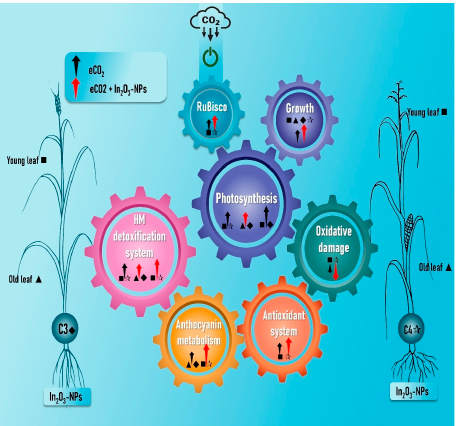
Figure 7. Infographic diagram that summarizes the impact of eCO 2 and/or In 2 O 3 -NPs upon both old and young leaves of C3 and C4 plants. Black and red arrows indicate either increase or decline due to eCO 2 or eCO 2 + In 2 O 3 -NPs, respectively. Supplementary Materials: The following are available online at www.mdpi.com/xxx/s1, Figure S1: A photograph that illustrates the differential effects of eC2 either lonely or in combination with In2O3-NPs upon the biomass of C3 and C4 plants, Table S1: A three-way ANOVA for the effect of treatment (Trt.) with eCO2, the plant species (Sp.) and the stage of plant leaf (St.) as well as their interaction on the biomass and photosynthesis as well as the molecular antioxidants and the oxida- tive markers (numbers represent F values; ns = non-significant; * = P < 0.05; ** = P < 0.01; *** = P < 0.001, **** = P < 0.0001). Table S2: A three-way ANOVA for the effect of treatment (Trt.) with eCO2, the plant species (Sp.) and the stage of plant leaf (St.) as well as their interaction on the ascorbate/glu- tathione biosynthetic pool as well as detoxification system and anthocyanin metabolism (numbers represent F values; ns = non-significant; * = P < 0.05; ** = P < 0.01; *** = P < 0.001, **** = P < 0.0001) Author Contributions: Conceptualization, M.M.Y.M. and H.A.; methodology, M.M.Y.M., and H.A.; software, M.M.Y.M., H.A and I.I.S.; validation, M.M.Y.M., H.A and I.I.S.; formal analysis, I.I.S. and M.A.B.; investigation, I.I.S., H.A., M.M.Y.M., M.A.B. and A.T.; resources, M.M.Y.M., H.A.; data cu- ration, M.M.Y.M. and H.A.; writing—original draft preparation, M.M.Y.M. and H.A.; writing—re- view and editing, M.M.Y.M., H.A., I.I.S., A.T.; visualization, I.I.S.; project administration, I.I.S., A.T., and M.A.B.; funding acquisition, I.I.S., and A.T.. All authors have read and agreed to the published version of the manuscript.